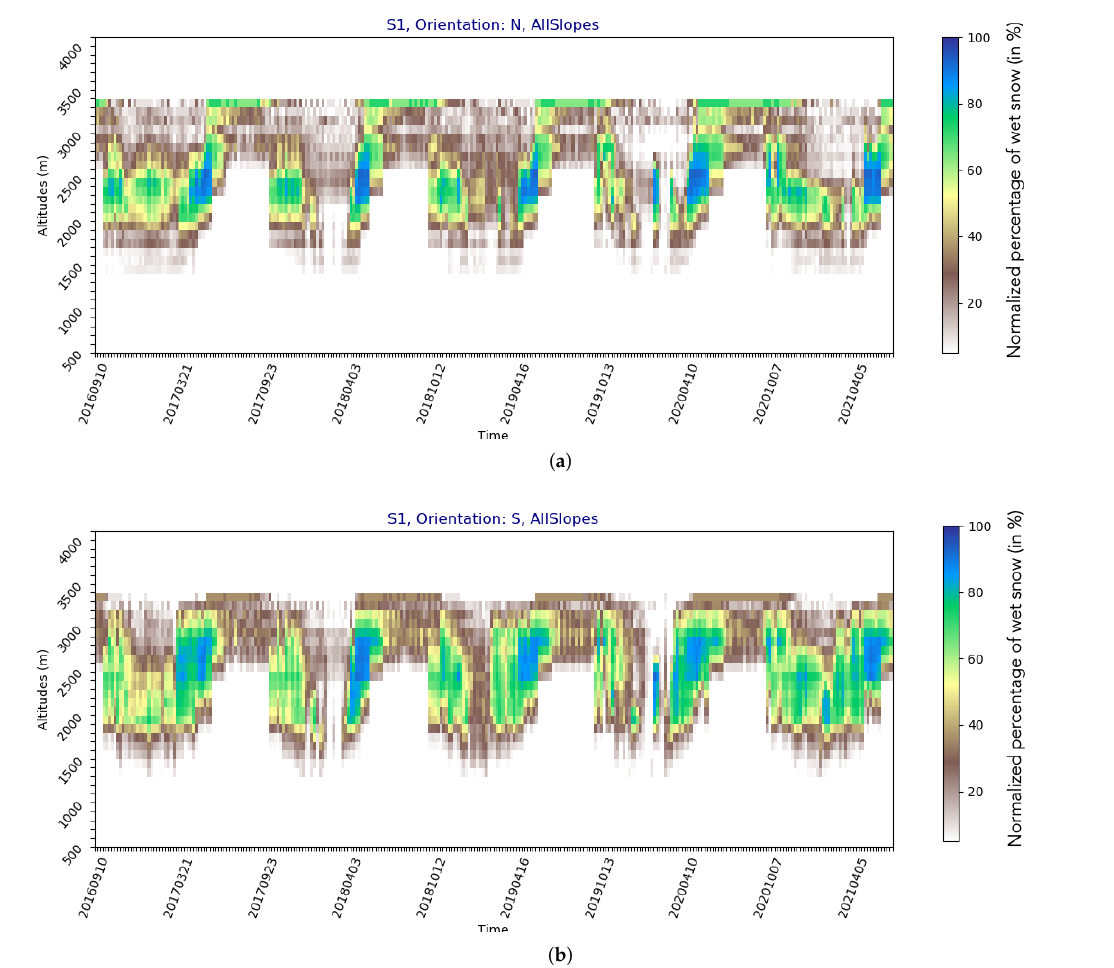
Figure 14. Altitude–Time diagram with the normalized percentage of wet snow-covered pixels by classes of elevation and time for Sentinel-1 descending SWS products for the Grandes-Rousses massif. Results are given for ( a ) northern and ( b ) southern orientations,